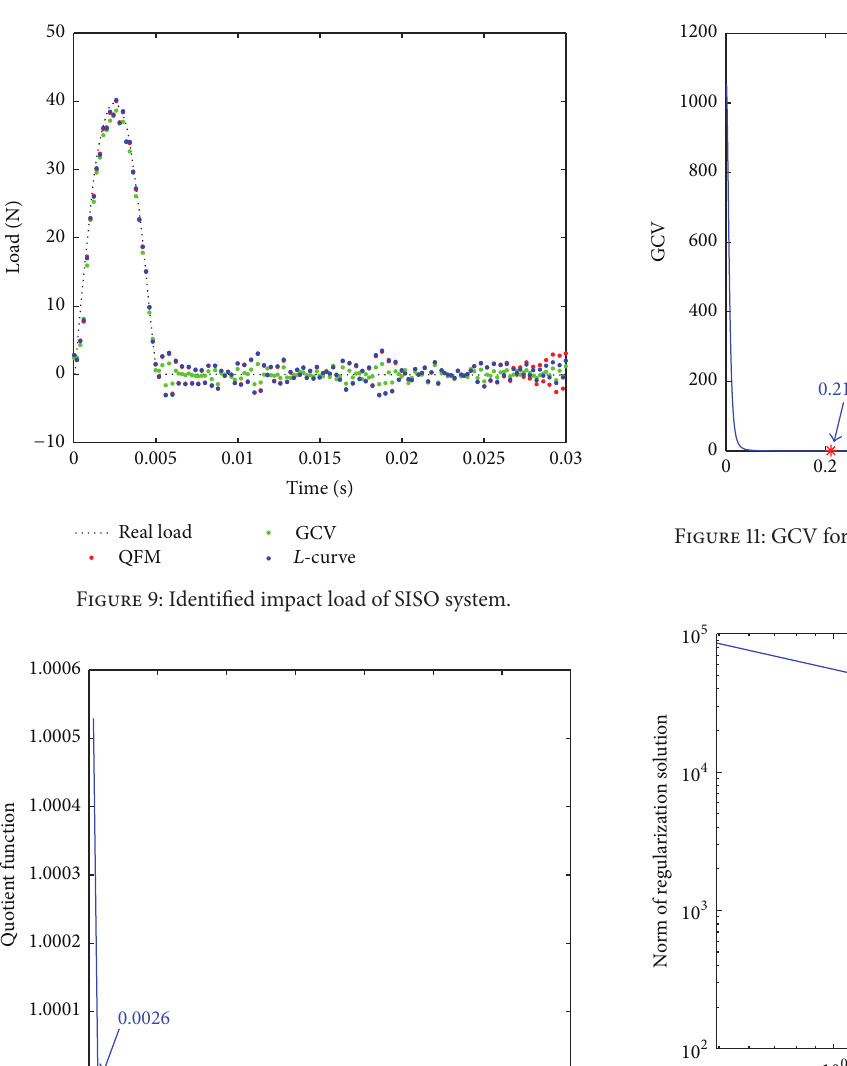
Norm of Figure 12: L -curve for sine load identification of SISO